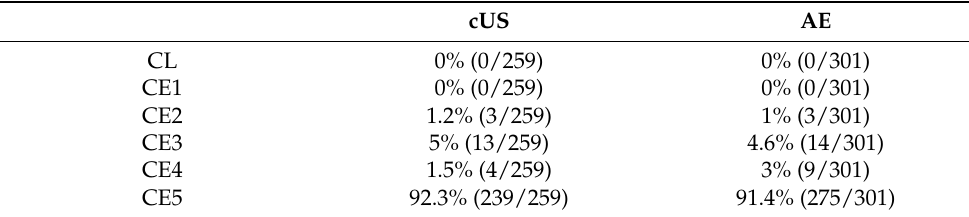
Table 5. Hydatid cysts detected through ultrasonographic and anatomopathological examination of the liver.